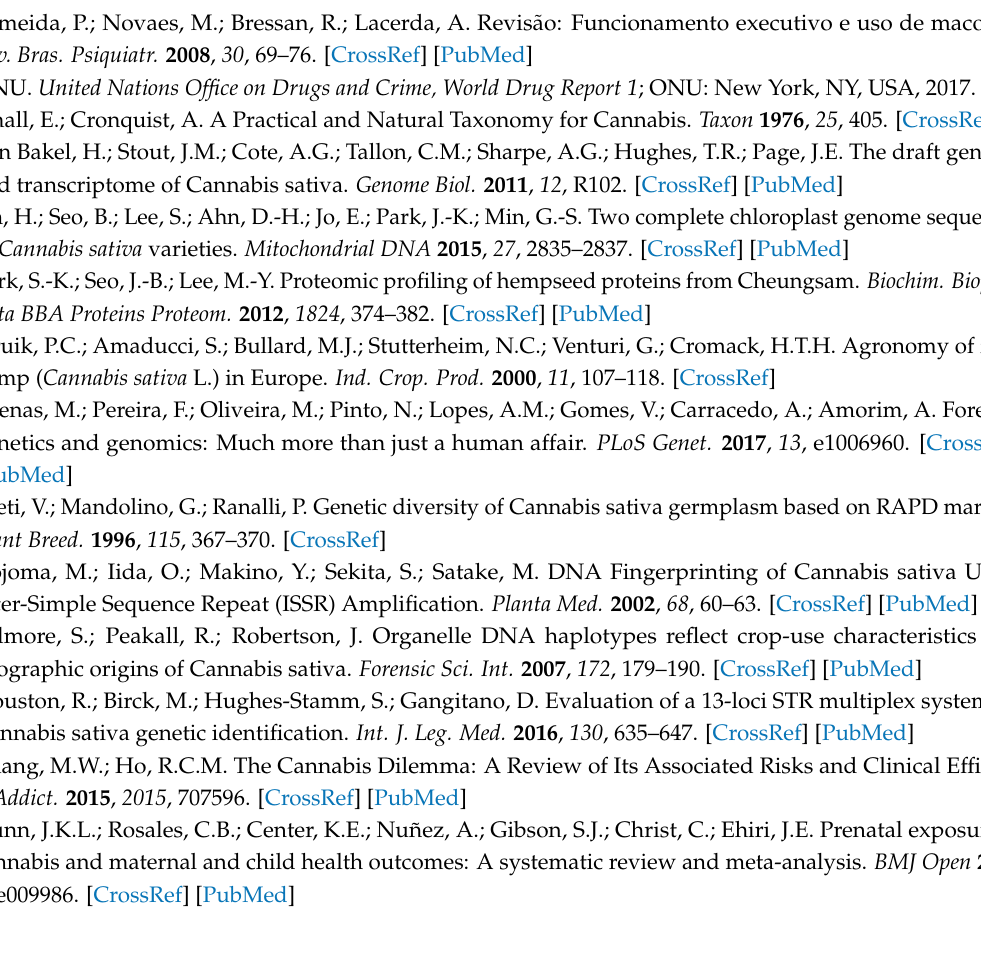
Figure S1: Absolute number of publications on Cannabis recovered from the Scopus platform using six different search arguments for each country, grouped by continents, Figure S2: Flowchart of the scientific fields from the searched studies after the individual screening involving any keywords in this